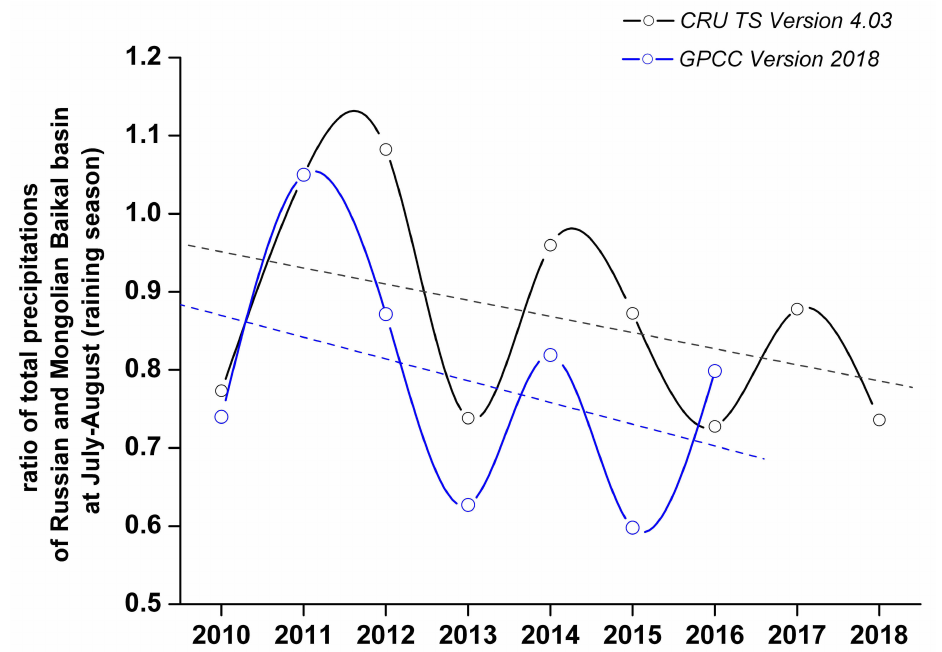
Figure 12. The ratios of total precipitations, in the Russian and in the Mongolian parts of the Baikal basin, during the wet period (July–August) are presented. The calculations were done using the CRU TS (black line) and by the GPCC (blue line) precipitation